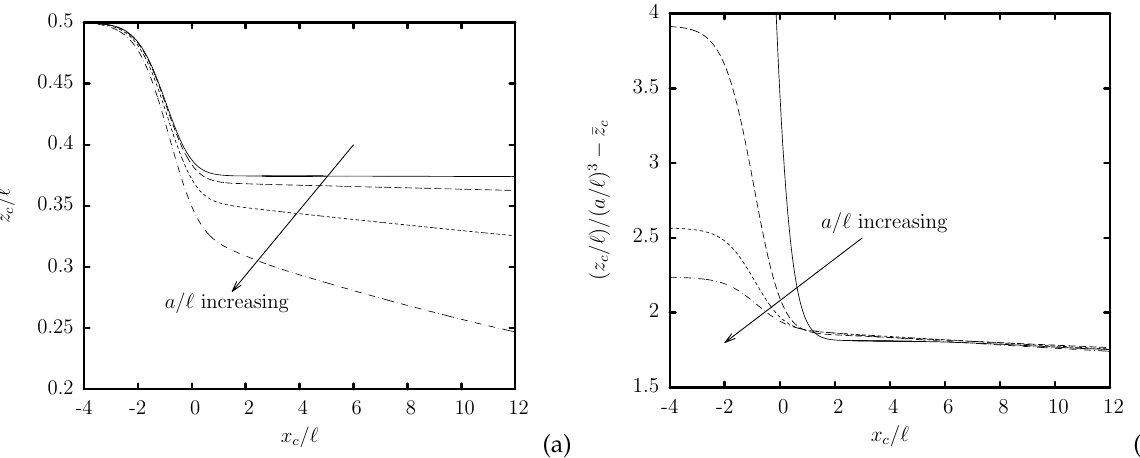
Figure 5. Capsule properties as a function of the centroid x c , for a Skalak capsule with Ca = 0.1, C = 1, λ = 1, z 0 c / (cid:96) = 0.5 and capsule sizes a / (cid:96) = 0.2,0.4,0.6,0.8 moving inside the constriction. Our results for a / (cid:96) = 0.1,0.2 are practically identical. ( a ) Capsule centroid z c . ( b ) As in ( a ) but for the scaled centroid ( z c / (cid:96) ) / ( a / (cid:96) ) 3 have practically the same value at x c / (cid:96) =